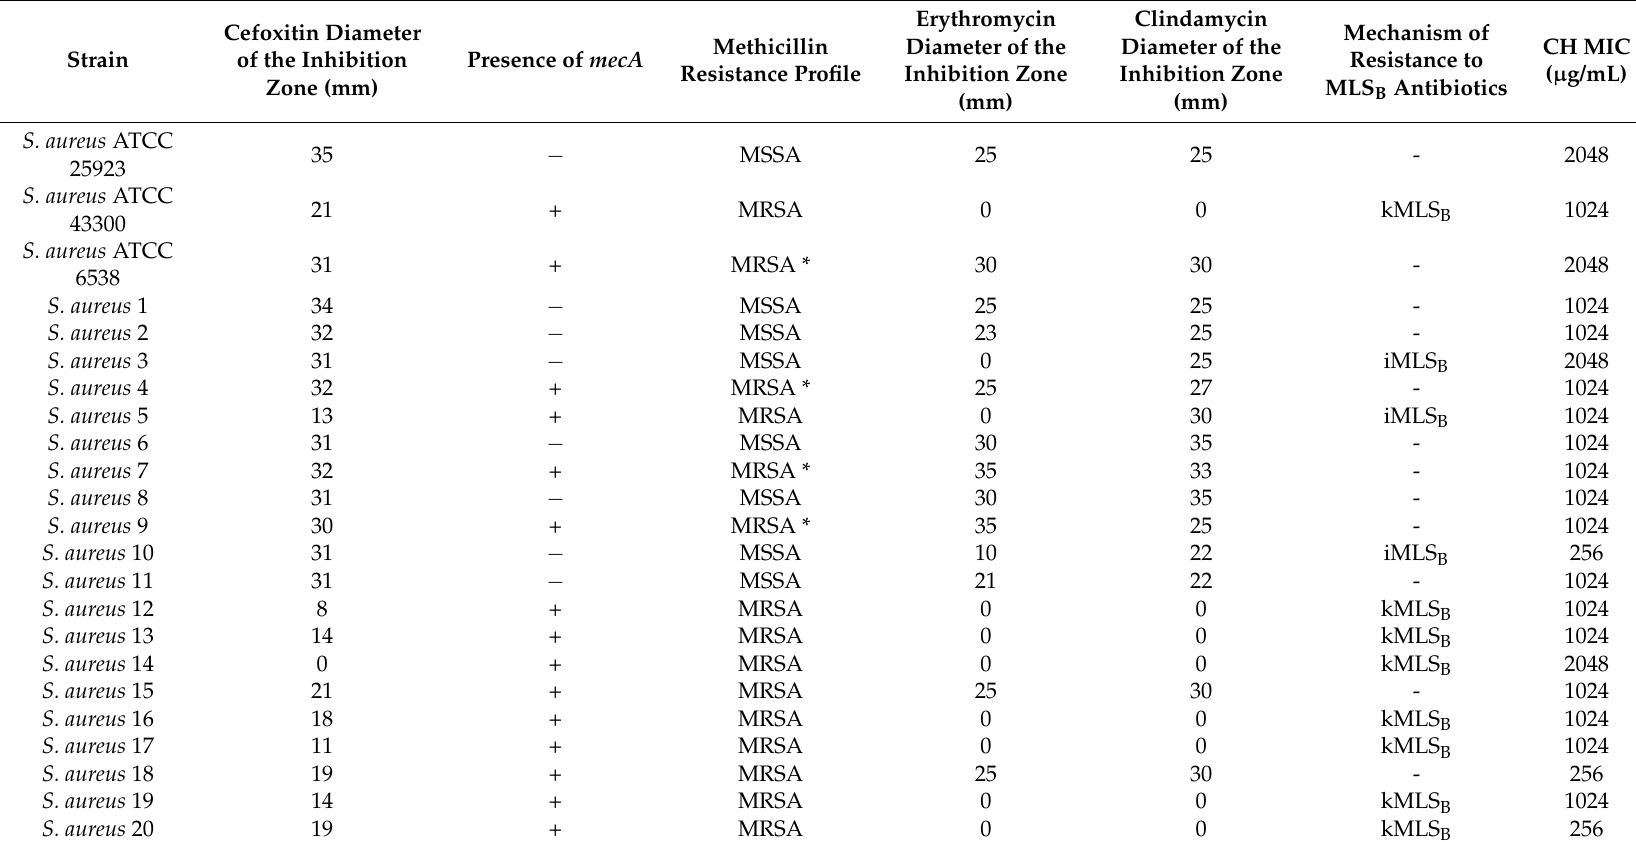
Table 1. Profile of resistance to methicillin and MLS B antibiotics for examined strains and MIC of CH against examined S. aureus strains. Cefoxitin Diameter Strain of the Inhibition Presence of Zone (mm)